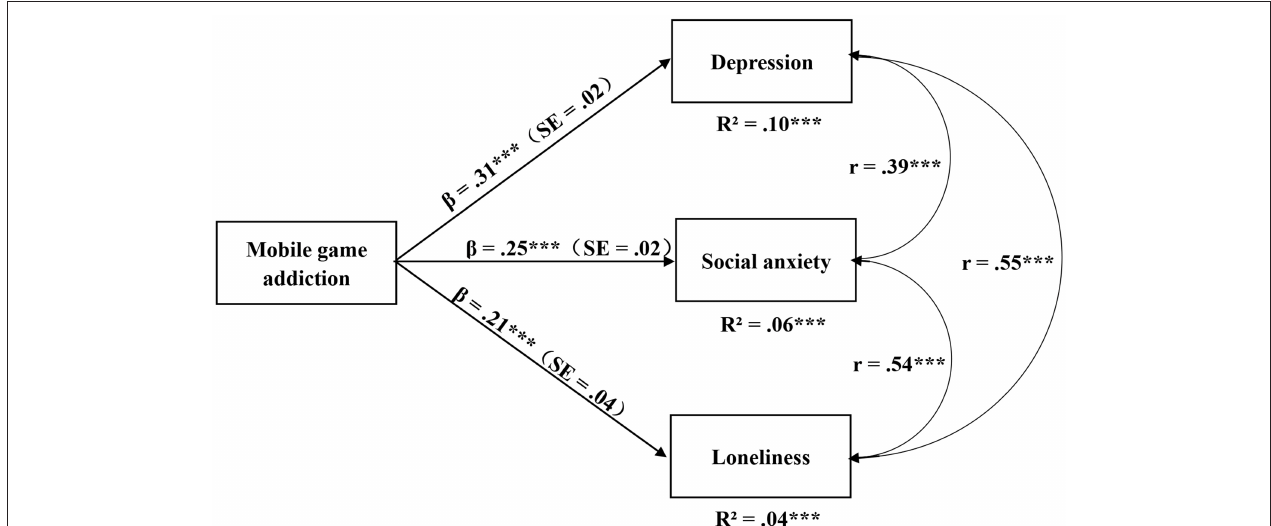
FIGURE 1 | The Structural Modeling on the relation between mobile game addiction and depression, social anxiety, and loneliness. *** p < 0.01.